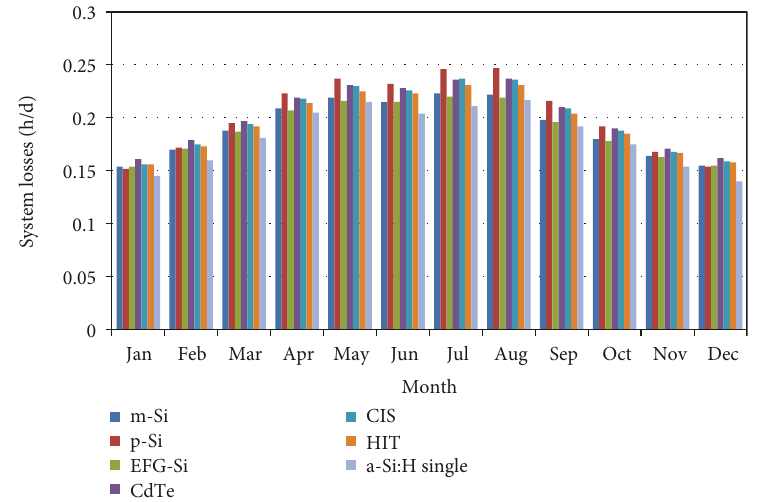
Figure 9: Monthly average system losses of seven PV module